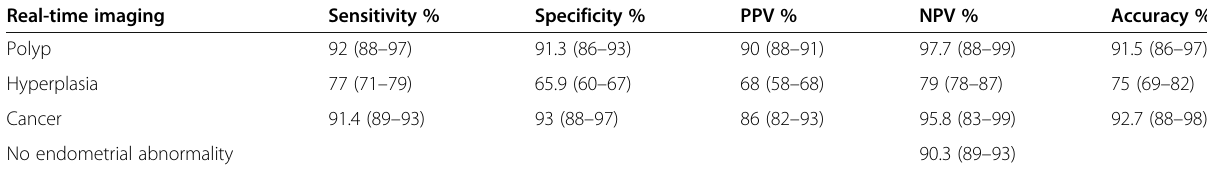
Table 1 Accuracy of real-time imaging in the diagnosis of four endometrial categories (polyp, hyperplasia, cancer, and no endometrial abnormality) compared to pathology Real-time